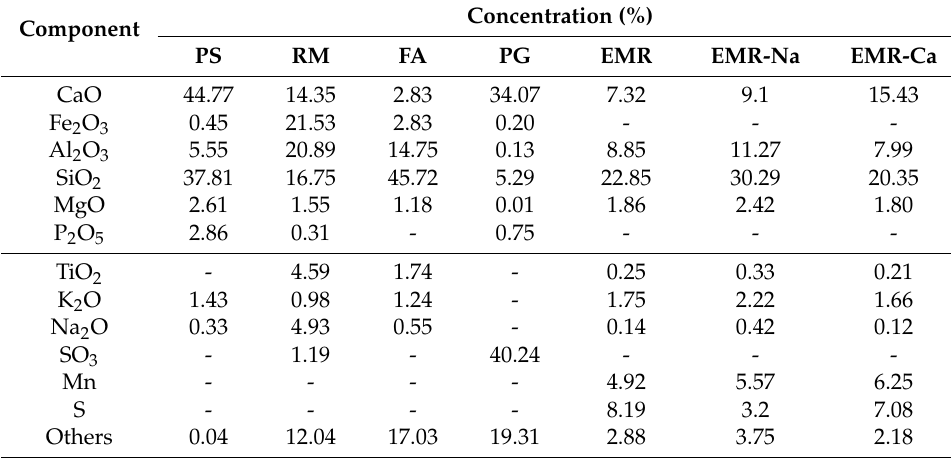
Table 3. Major components in seven solid